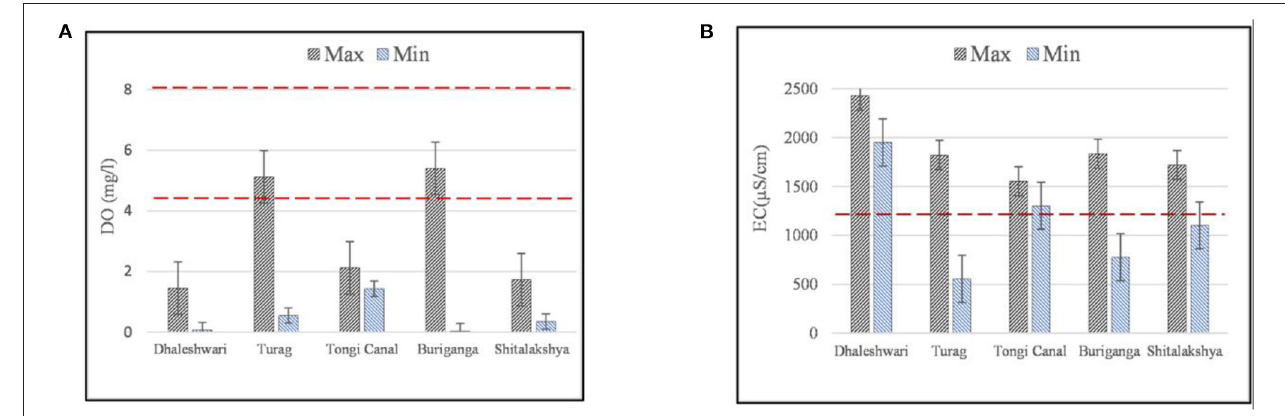
FIGURE 5 | (A,B) Maximum and minimum concentrations of DO and EC for the selected outfalls along the peripheral rivers of Dhaka (error bars indicate standard error of mean and red dotted lines indicate the Bangladesh standards of water quality according to